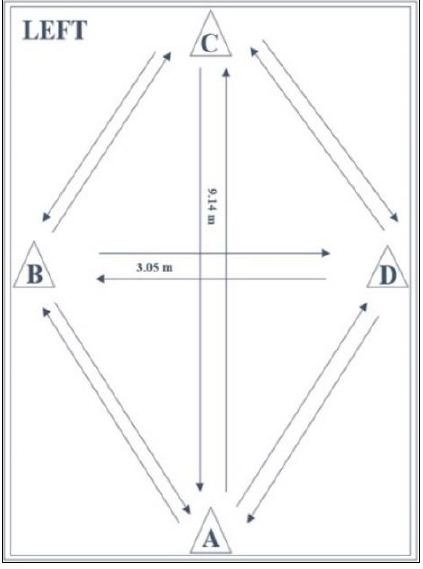
Figure 2. The lower extremity functional test (LEFT) [11,27].